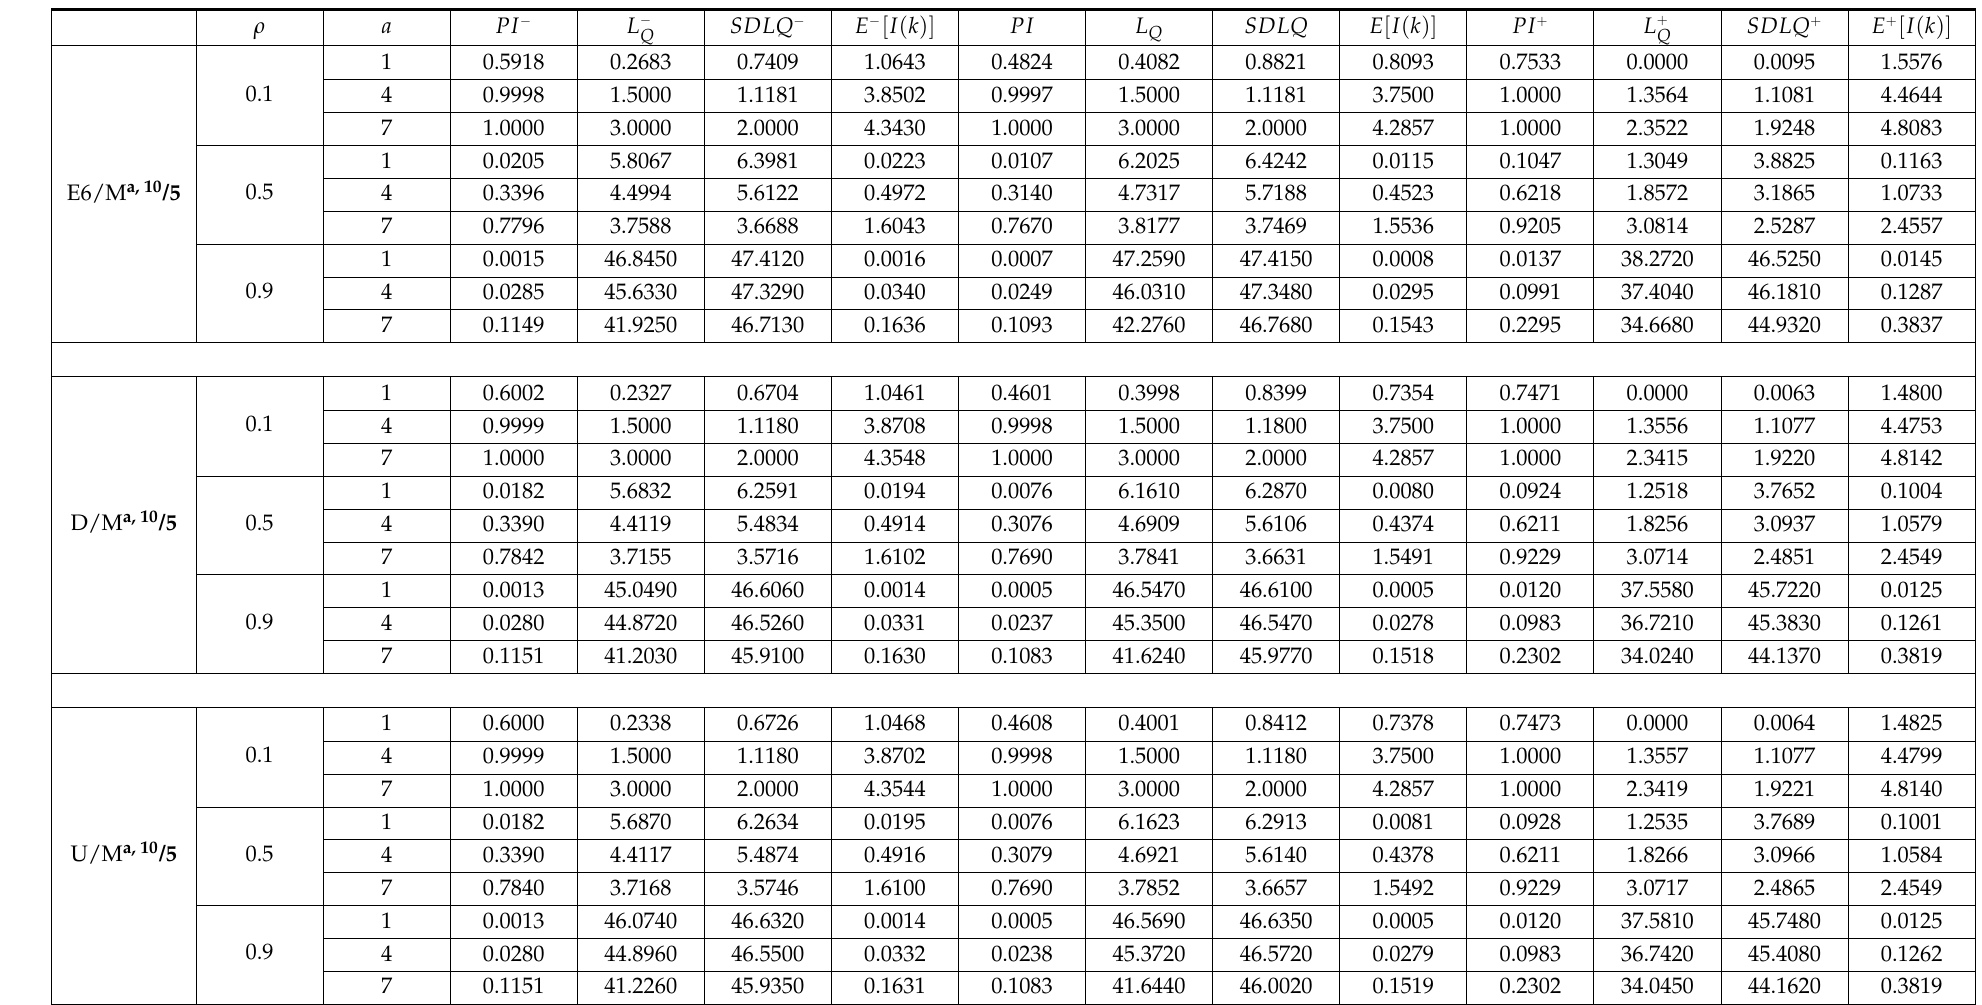
Table 8. Comparison of performance measures of E 6 /M a ,10 /5, D/M a ,10 /5, and U/M a ,10 /5 for idle servers, a = 1, 4, 7, ρ = 0.1, 0.5, 0.9, ε = 10 − 20